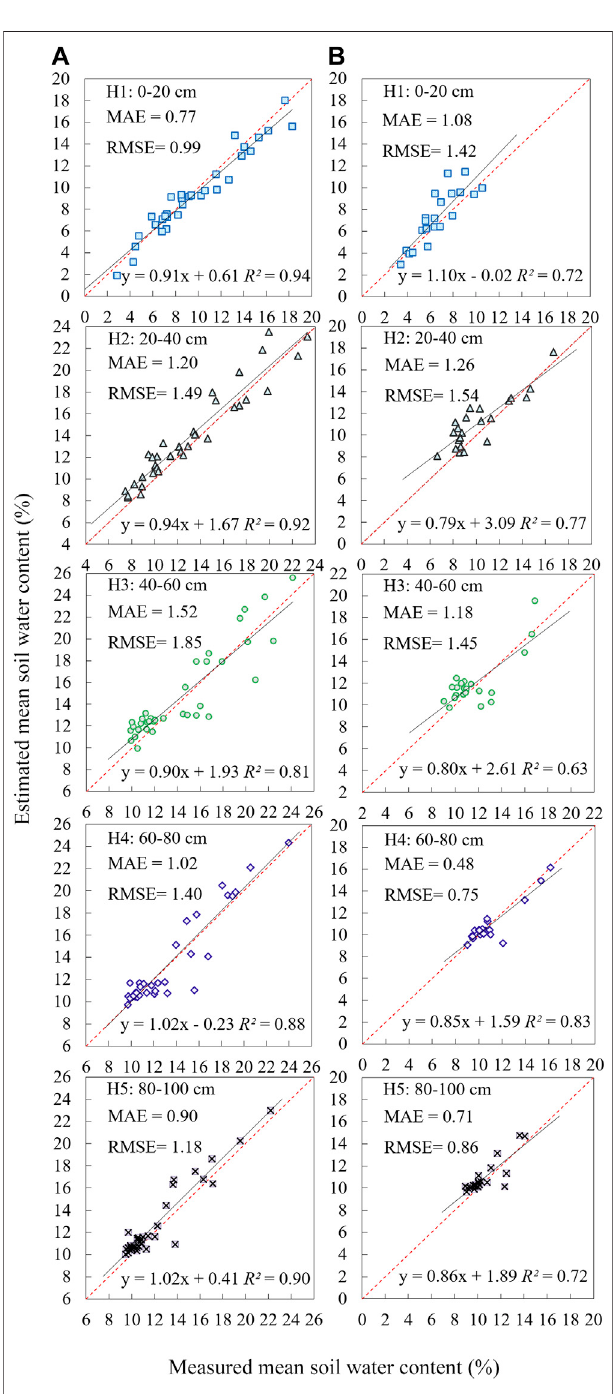
FIGURE 7 | Plot mean soil water content vs. SWC at representative locations for the 0 – 20, 20 – 40, 40 – 60, 60 – 80, and 80 – 100 cm soil layers (location 18 for the fi ve soil layer) during the (A) rainy season and (B) dry season.